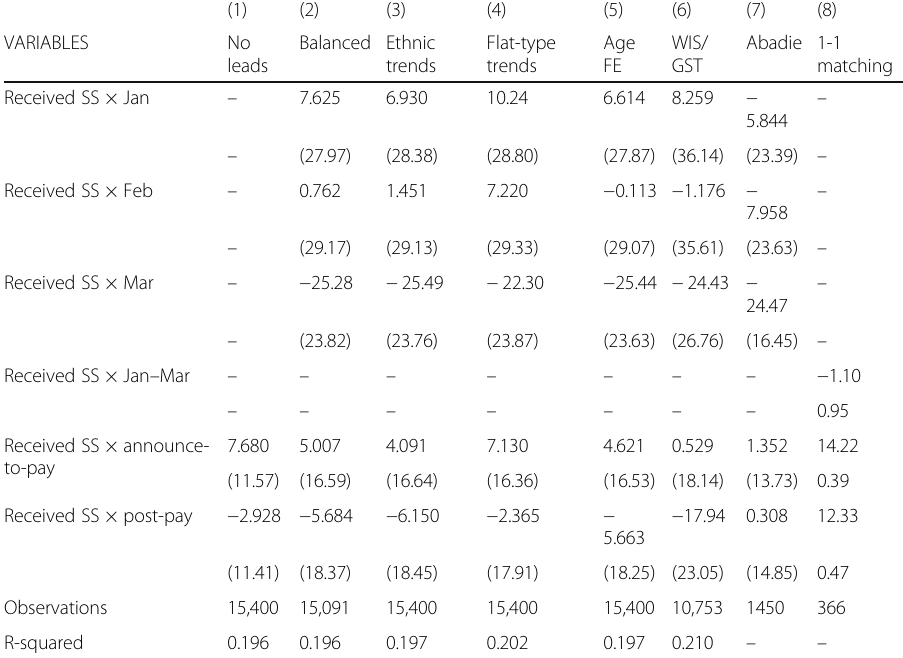
Table 20 Robustness check for impact of receiving SSS payouts on amount of private cash transfers